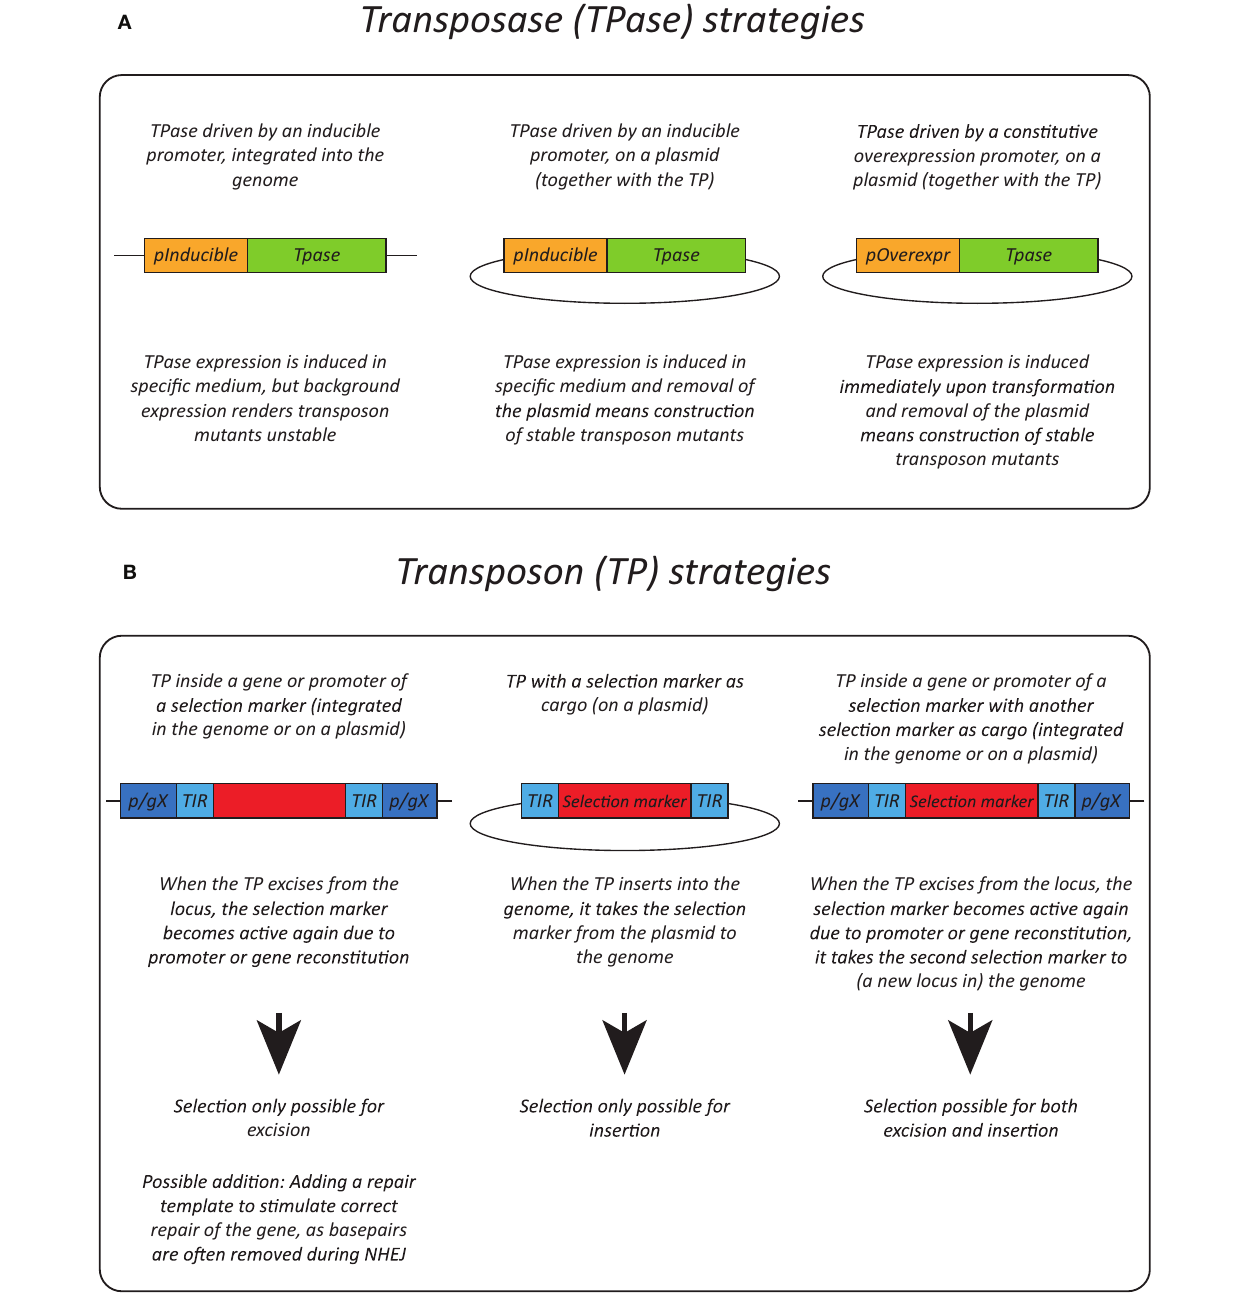
FIGURE 2 | Transposition strategies in fungi. (A) Different strategies used for transposase (TPase) expression in yeasts. (B) Different selection methods used for transposon (TP) excision and insertion in yeasts. p/gX, promoter/gene X.